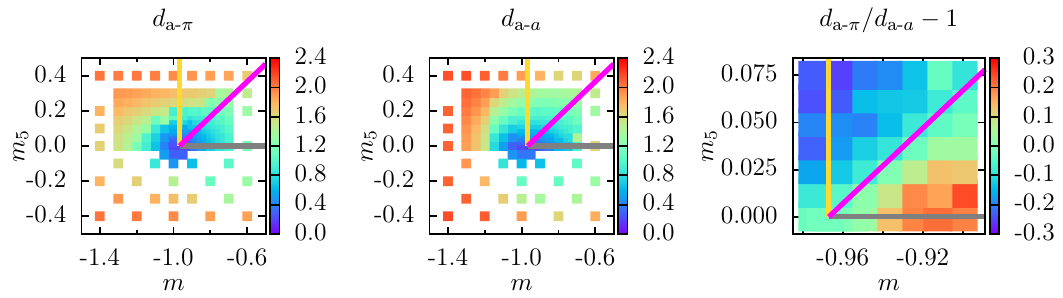
Figure 6 . Parameter scan in m and m 5 on a 8 3 × 16 lattice. In the left and middle plot the dominant mass contribution d of the a- π (connected part of the a- η 0 ) resp. a- a (connected part of the a- f 0 ) are shown. The right plot combines those results in the subtracted ratio d a- π /d a- a − 1 . Note the different axis ranges. The colored lines (gray, magenta and yellow) are discussed in the